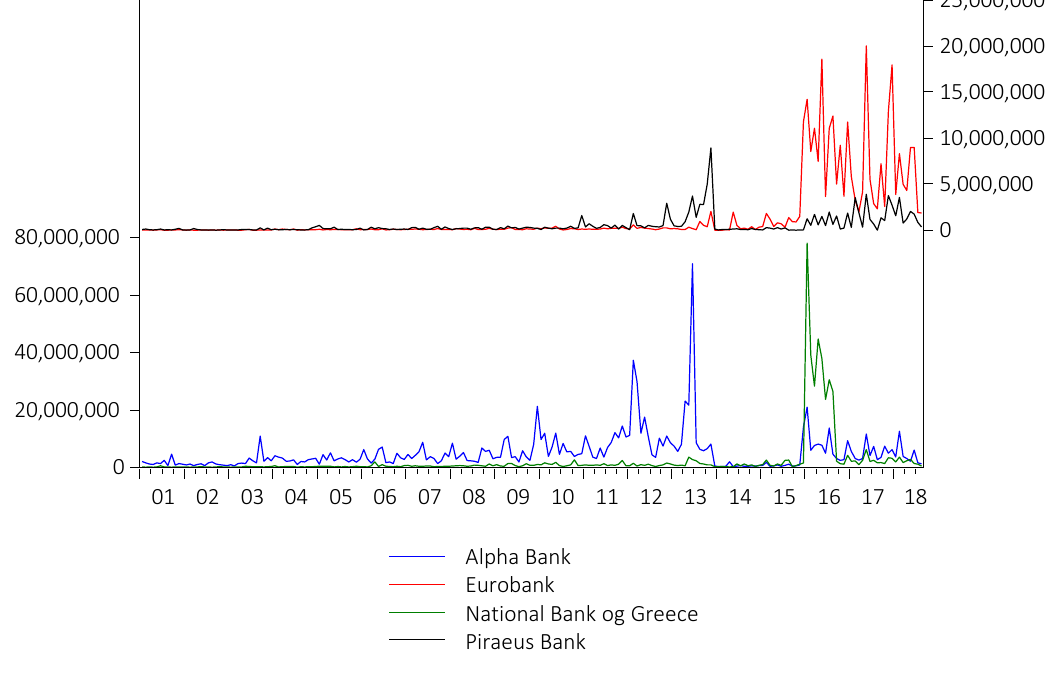
Figure 1. Greek banks’ volume (in y axes) evolution from 2001 to